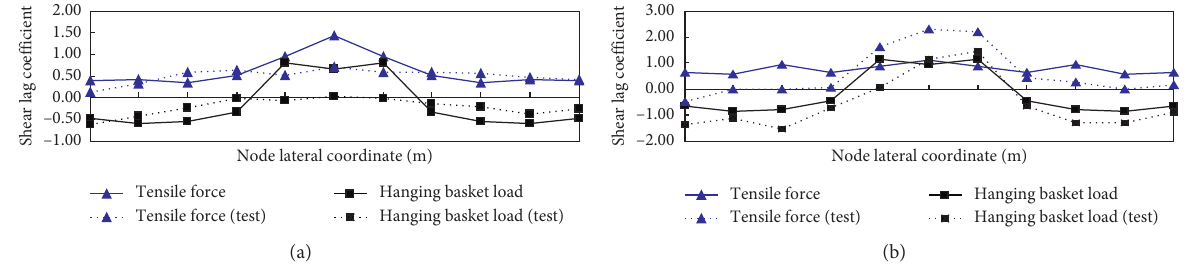
Figure 8: Shear lag coefficient variations in G5 and G6 (Condition 1): (a) G5 section; (b) G6 section.